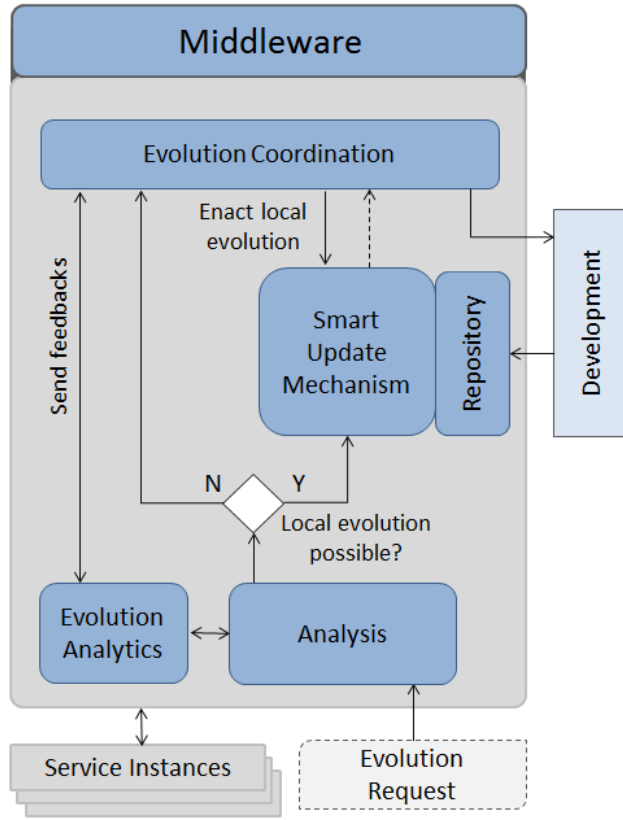
Figure 3. Architecture of the